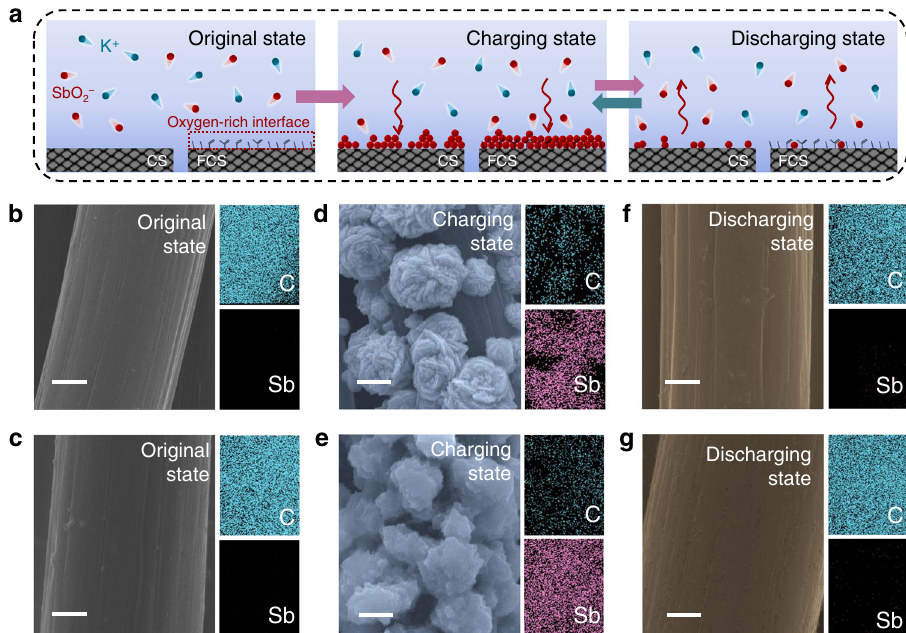
Fig. 1 Charge storage mechanism investigations of stibium. a Schematic illustration of the charge storage mechanism of the Sb anode in 1 M KOH and 0.027M C 8 H 4 K 2 O 12 Sb 2 electrolyte. The arrows indicate the direction of Sb metal stripping/plating. b – g SEM images and mapping of b CS and c FCS in original state; d Sb/CS and e Sb/FCS in charging state; f Sb/CS and g Sb/FCS in discharging state. Scale bars: 2 μ